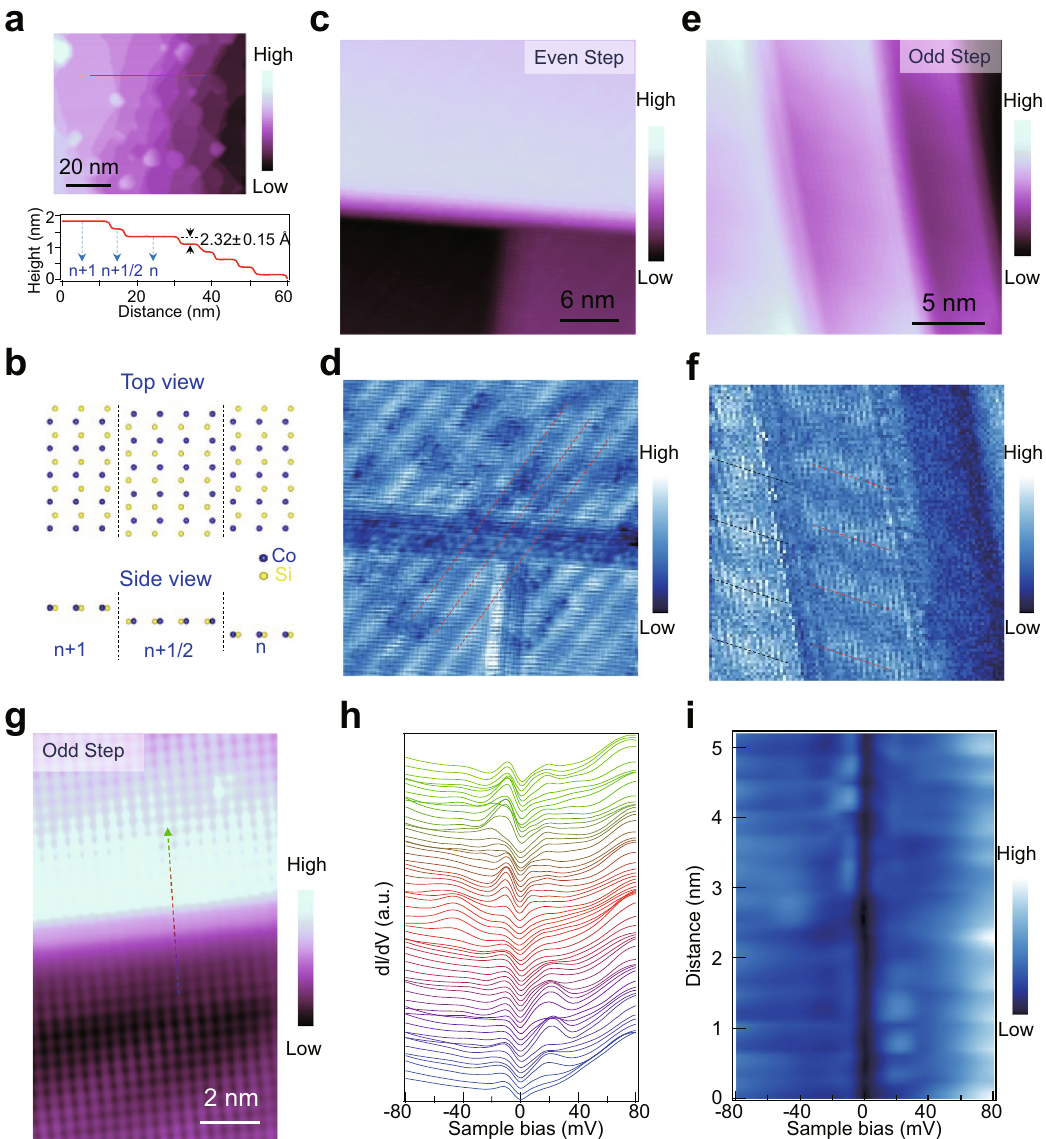
Fig. 3 Spatial evolution of CDW pattern and d I /d V spectra across steps. a Upper panel, a surface region showing terraces with different indices. Scanning settings: V s = − 1 V, I t = 0.6 nA. Lower panel, height pro fi le along the red line in the upper panel, showing sequential steps with half of the lattice constant along c axis. b Schematic drawing of the atomic arrangement of the terraces. The surface atoms on terraces possess n and n + 1/2 indices, and are linked with glide-mirror symmetry. STM image ( c ) and d I /d V map under zero bias ( d ) of a region with steps. The height difference between the highest (upper part in ( c )) and lowest (lower left part in ( c )) terraces is 2 times of the c-axis lattice constant c . The CDW stripes are in phase across even steps, as outlined by red dashed lines. Scanning settings of c : V s = − 200 mV, I t = 0.1 nA. STM image ( e ) and d I /d V map under zero bias ( f ) of a region with sequential odd steps with heights of 2.5 c . The CDW stripes are out of phase across odd steps, as outlined by red and black dashed lines. Scanning settings of ( e ): V s = − 200 mV, I t = 0.1 nA. g STM image of an odd step. Scanning settings: V s = 500 mV, I t = 0.1 nA. h , i , Waterfall plot and intensity map of d I /d